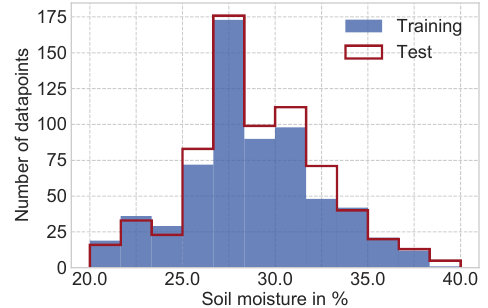
Figure 3. Distribution of the regression target variable (soil mois- ture) in the training (blue) and the test (red line) dataset.